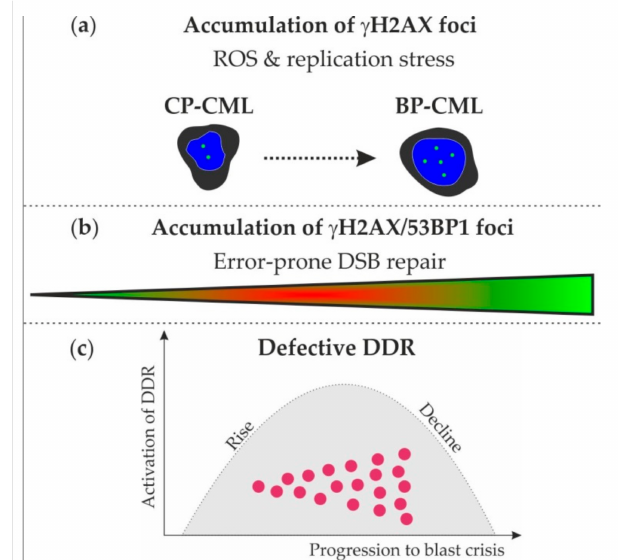
Figure 4. Model of genetic instability in CML. ( a ) Accumulation of γ H2AX foci (green) in nuclei (blue) of CP-CML and BP-CML may increase with reactive oxygen species (ROS)- and replication-stress-induced DNA damage. ( b ) Accumulation of γ H2AX / 53BP1 foci suggests progressive activation of error-prone DNA double-strand break (DSB) repair in the course from CP-CML towards BP-CML. ( c ) After initial activation of the DDR in hematopoietic cells, the DDR might finally decline in transformed CP- and BP-CML